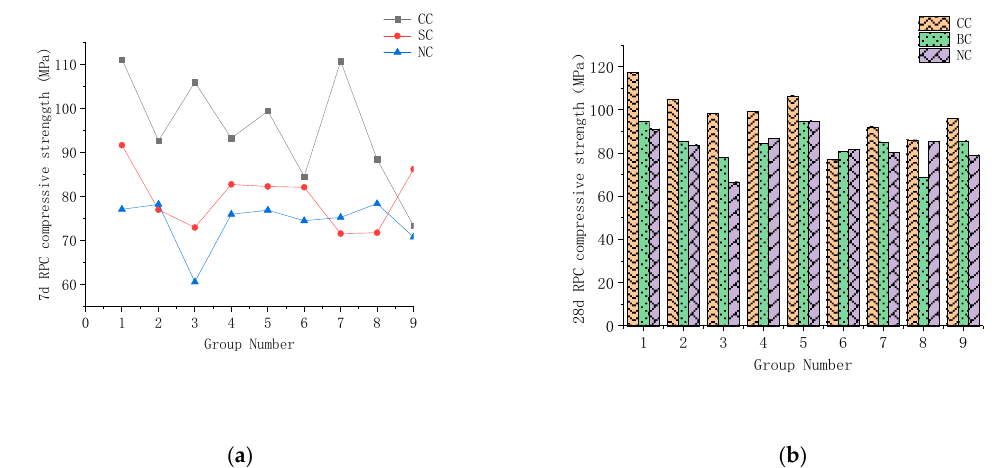
Figure 3. RPC compressive strength: ( a ) 7-day compressive strength; ( b ) 28-day compressive strength.